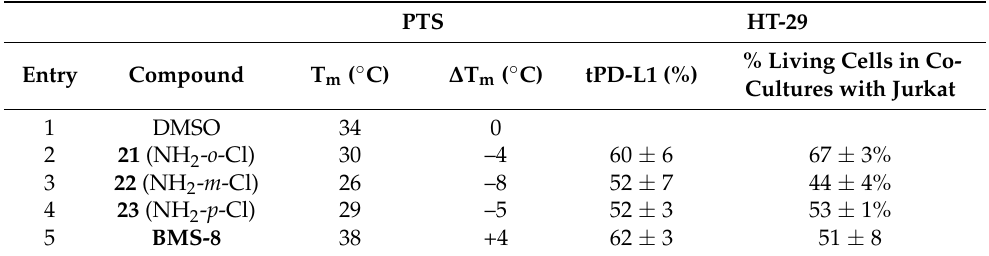
Table 5. PTS assay and correlation with results in HT-29 cells in the presence of compounds 21 – 23 1 .